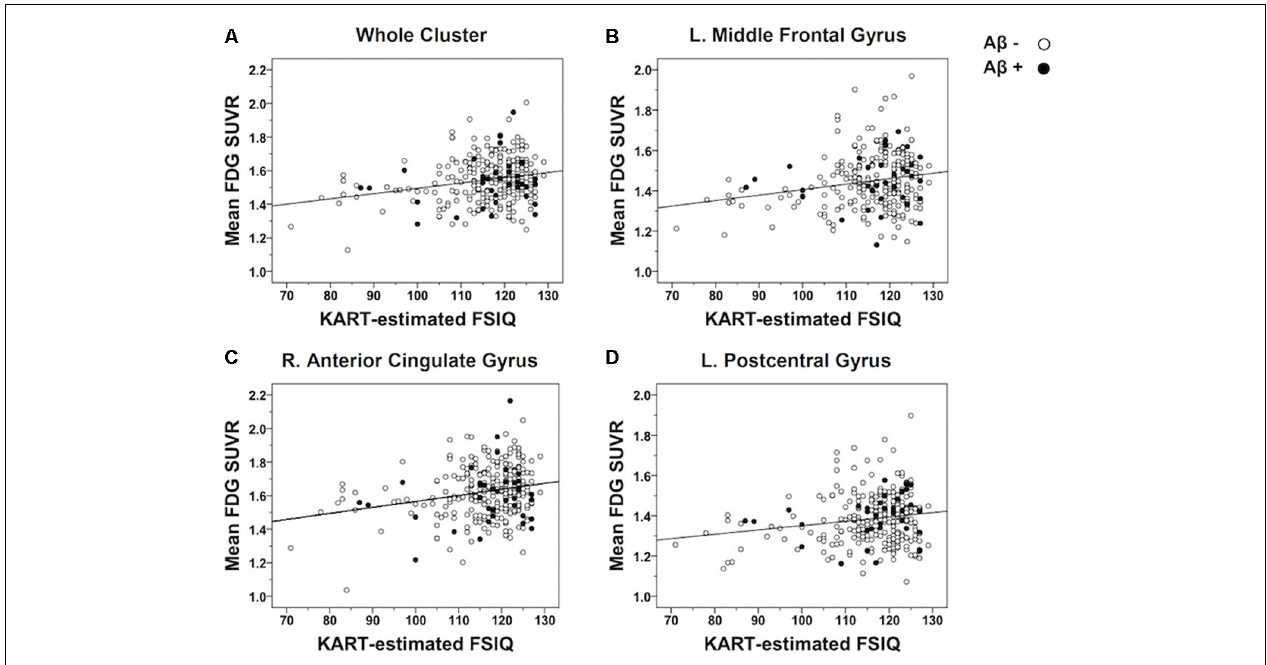
FIGURE 2 | Scatterplots demonstrating the strength of correlations between KART-estimated FSIQ score and regional glucose metabolism in all CN subjects. Mean FDG-PET SUVR values were extracted from the clusters of voxels showing a significant association with KART performance and examined the correlation with KART performance with using a partial correlation analysis adjusted for age and gender. There were positive significant correlations between KART-estimated IQ score and mean FDG-PET SUVR values in all clusters: (A) whole cluster; (B) left middle frontal gyrus; (C) right anterior cingulate gyrus; (D) left postcentral gyrus.